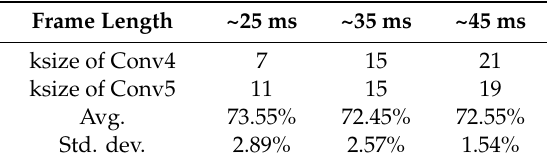
Table 3. Test accuracy with di ff erent frame length settings.